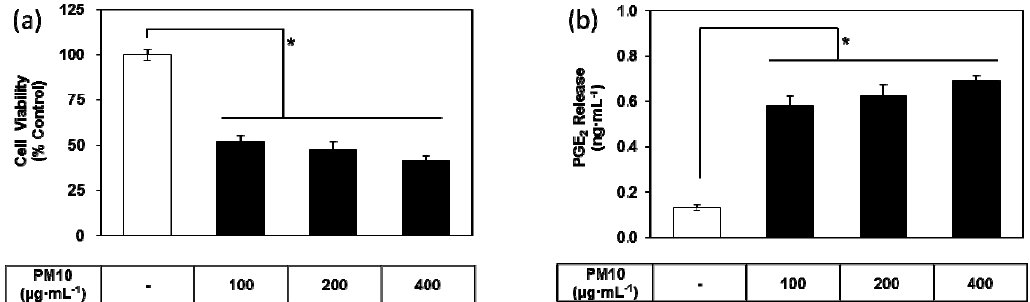
Figure 1. Effects of particulate matter less than 10 microns in diameter (PM10) on the viability and prostaglandin E 2 (PGE 2 ) release of HaCaT keratinocytes. Cells were treated with varying concentrations of PM10 for 48 h for the viability assay ( a ) and the PGE 2 assay ( b ). Control cells were treated with phosphate-buffered saline. Data are presented as mean ± standard deviation (SD) ( n = 4). All treatments were compared to the control using one-way analysis of variance (ANOVA) followed by Dunnett’s test. * p < 0.05.